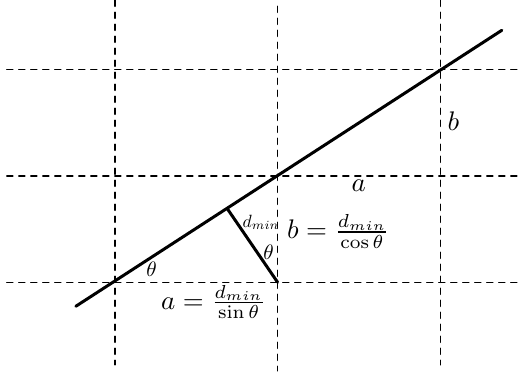
Figure 6. A partial view of a division that yields below (cid:96) triangles with d min height and sides a and b parallel to the x - and the y -axis,